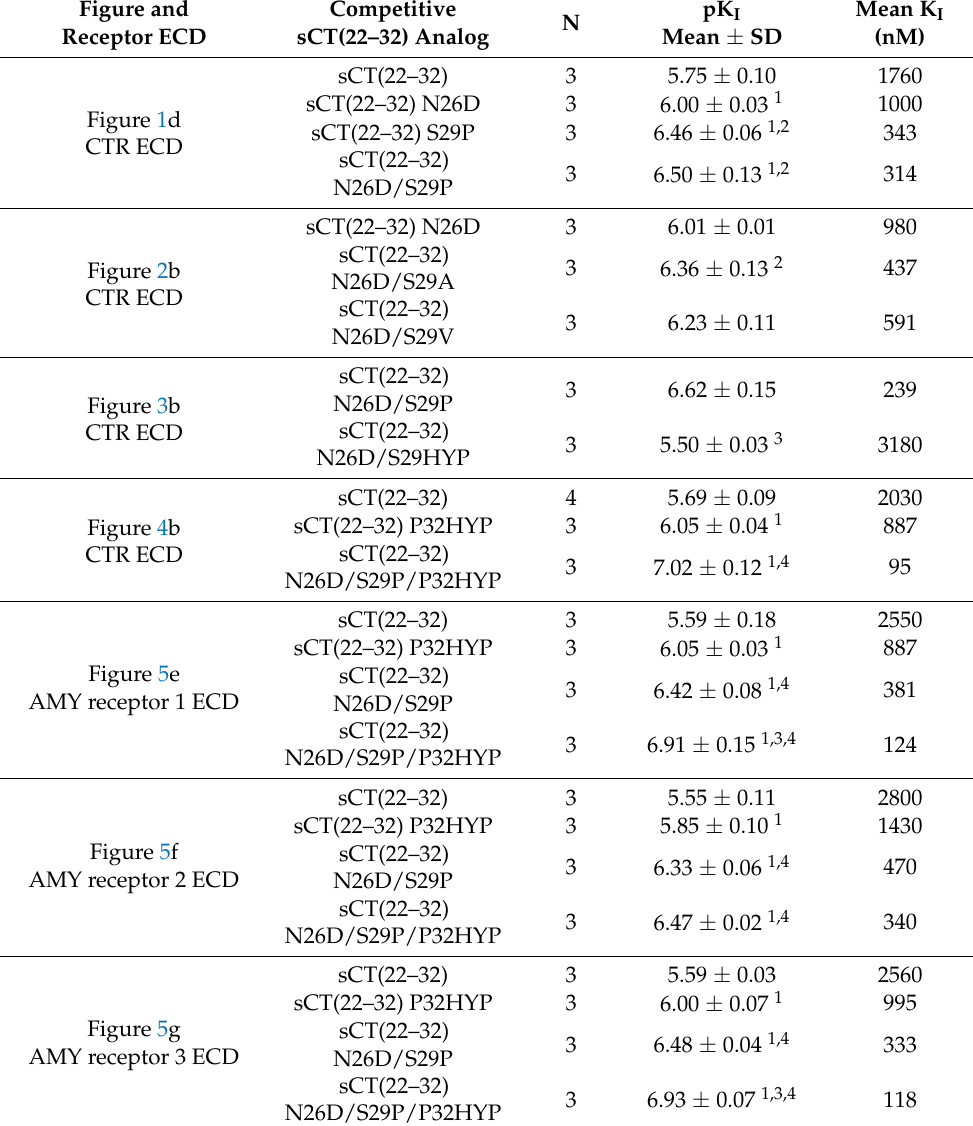
Table 2. The affinity of peptide analogs for CTR and AMY receptor